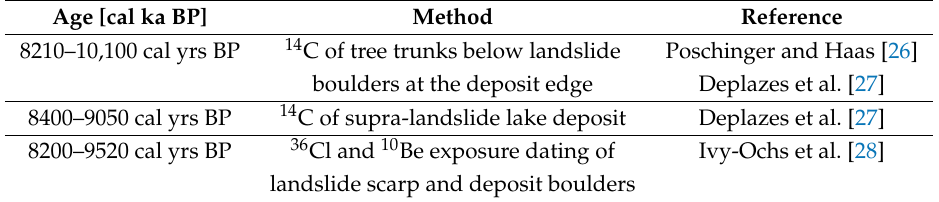
Table 1. Age ranges determined for the Flims